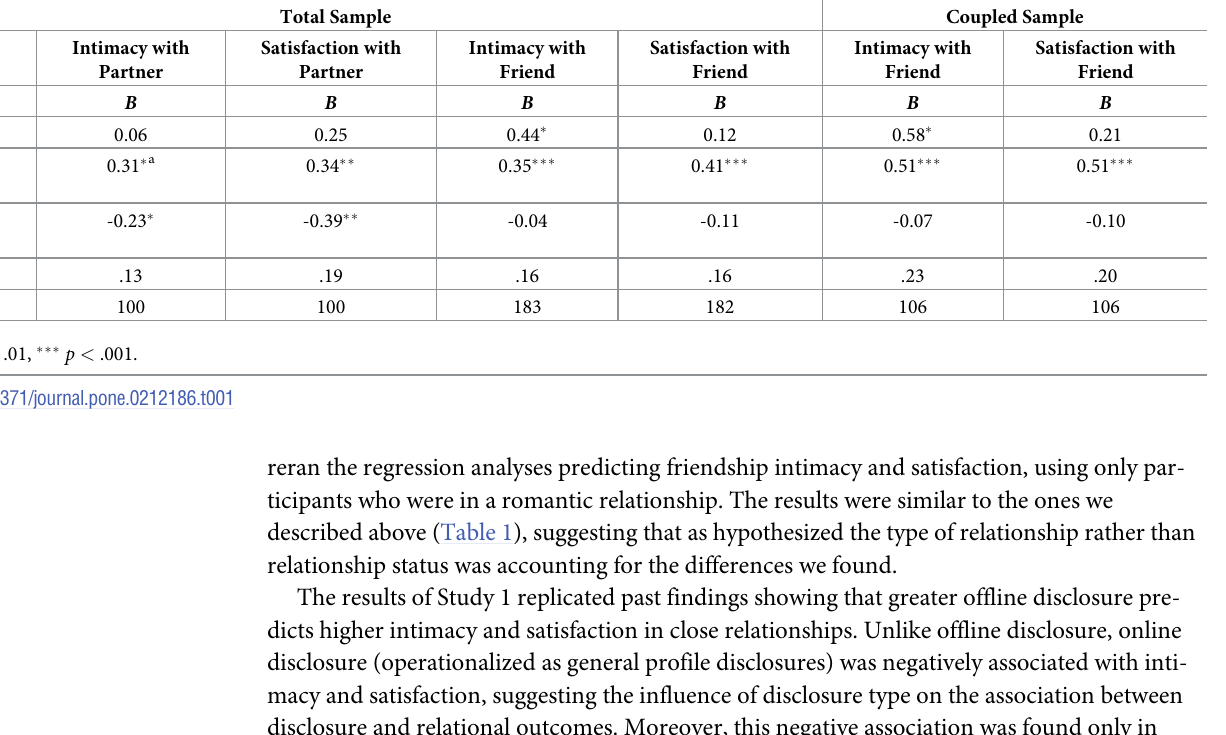
Table 1. Study 1 regression analyses predicting relationship intimacy and satisfaction in romantic relationships and